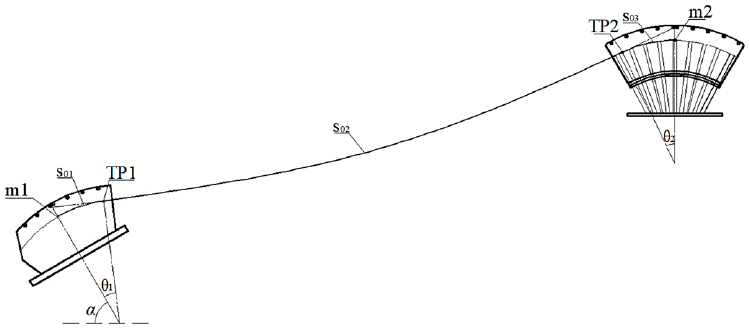
Figure 8. Calculation diagram of tangent point segment of cable strand.